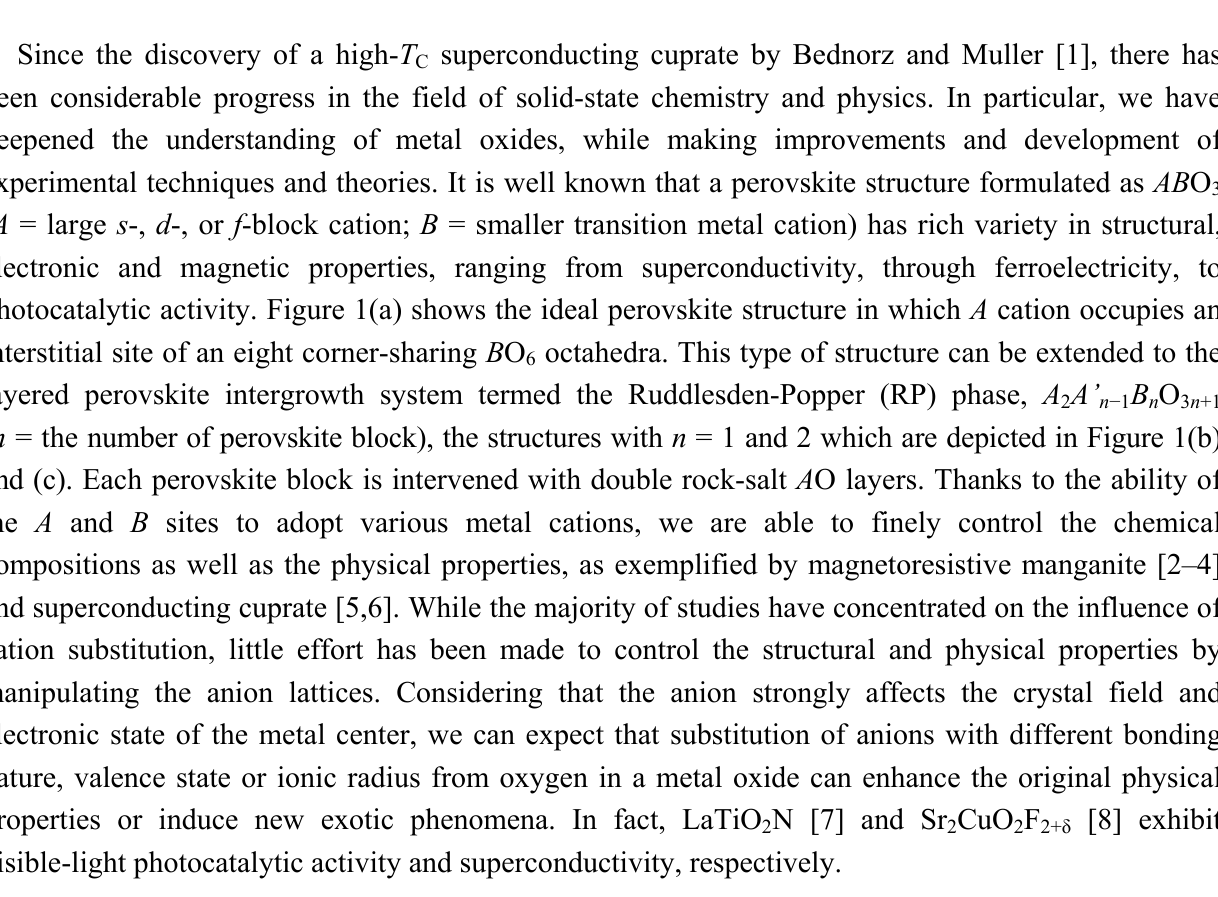
Figure 1. Structure of the ideal perovskite structure, A